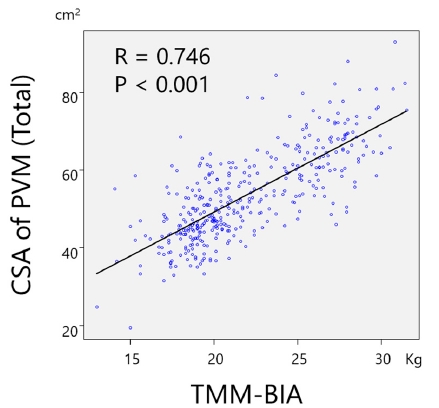
Figure 2. Correlation between TMM–BIA and the CSA of PVM. There was a significant correlation between TMM–BIA and the CSA of PVM with r = 0.746. TMM–BIA, trunk muscle mass measured by bioelectrical impedance analysis; CSA, cross-sectional area; PVM, paravertebral